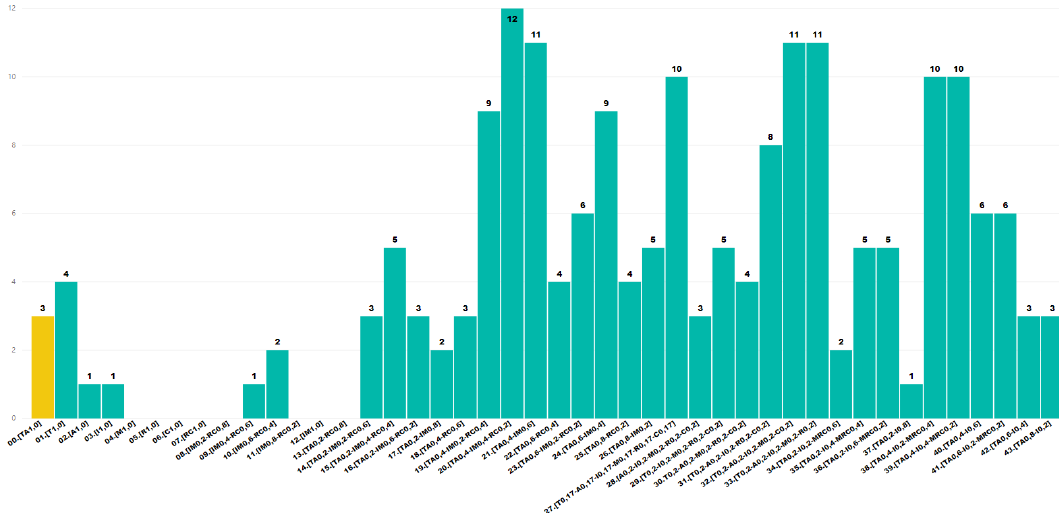
Figure 1. For each weighing combination, number of OHSUMED corpus with Kappa values close to the best Kappa